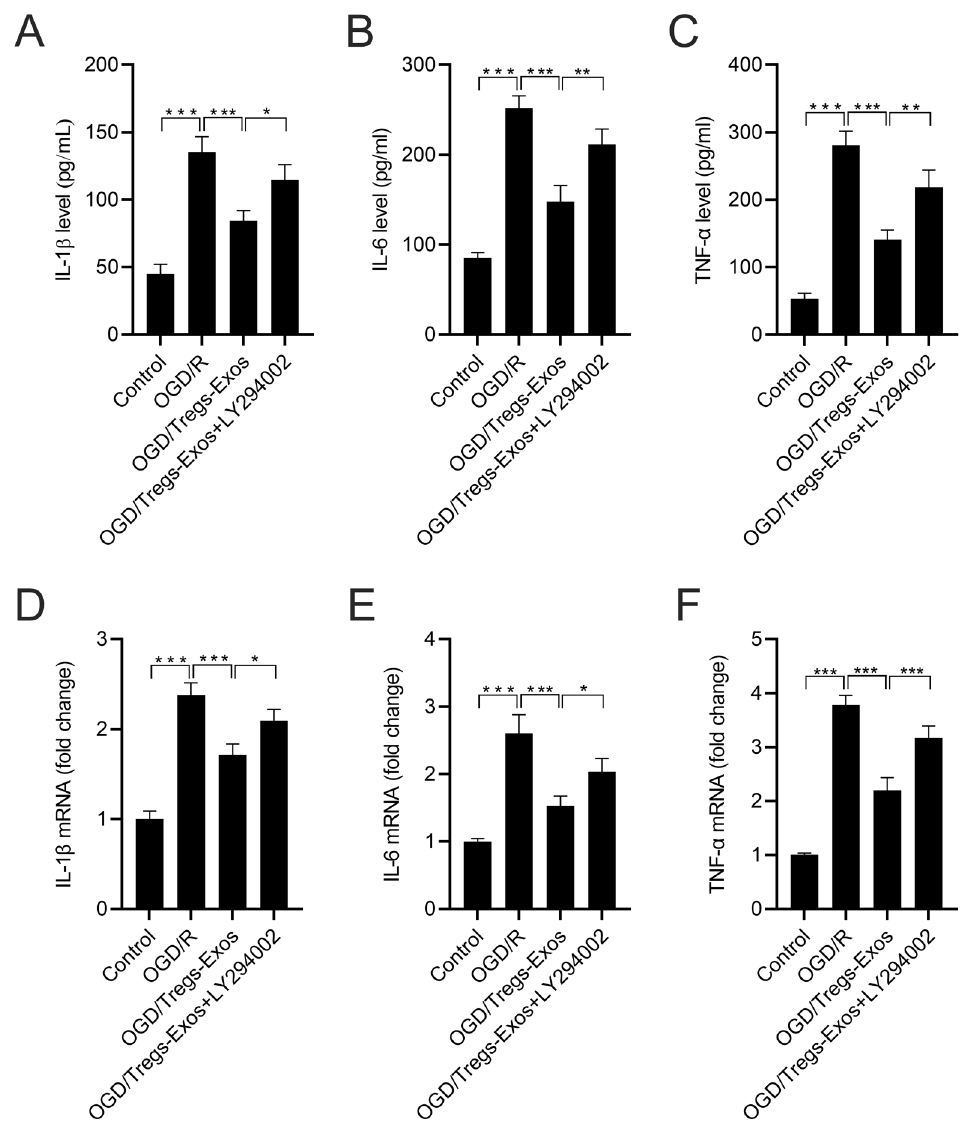
Figure 6 – LY294002 weakens the effect of Tregs-Exos on OGD/R-induced cell inflammation in BV-2 microglia. (A-C) Secreted levels of TNF-α, IL- 1β, and IL-6 from BV-2 microglia were assessed by ELISA assay. (D-F) qRT-PCR assay was performed to detect the mRNA levels of TNF-α, IL-1β, and IL-6. * p < 0.05, ** p < 0.01, *** p <